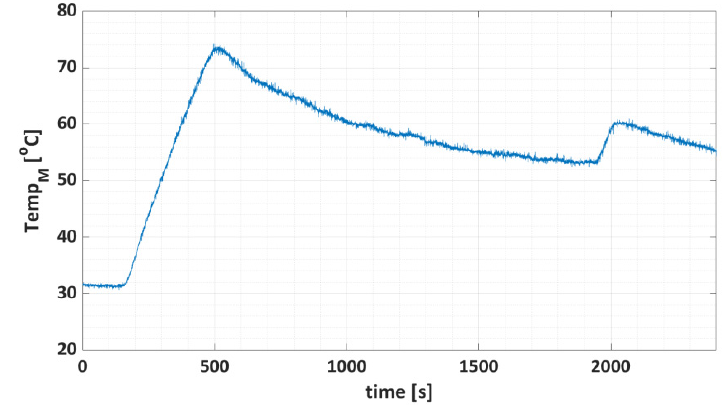
Figure 4. Motor temperature waveform during the testing profile.